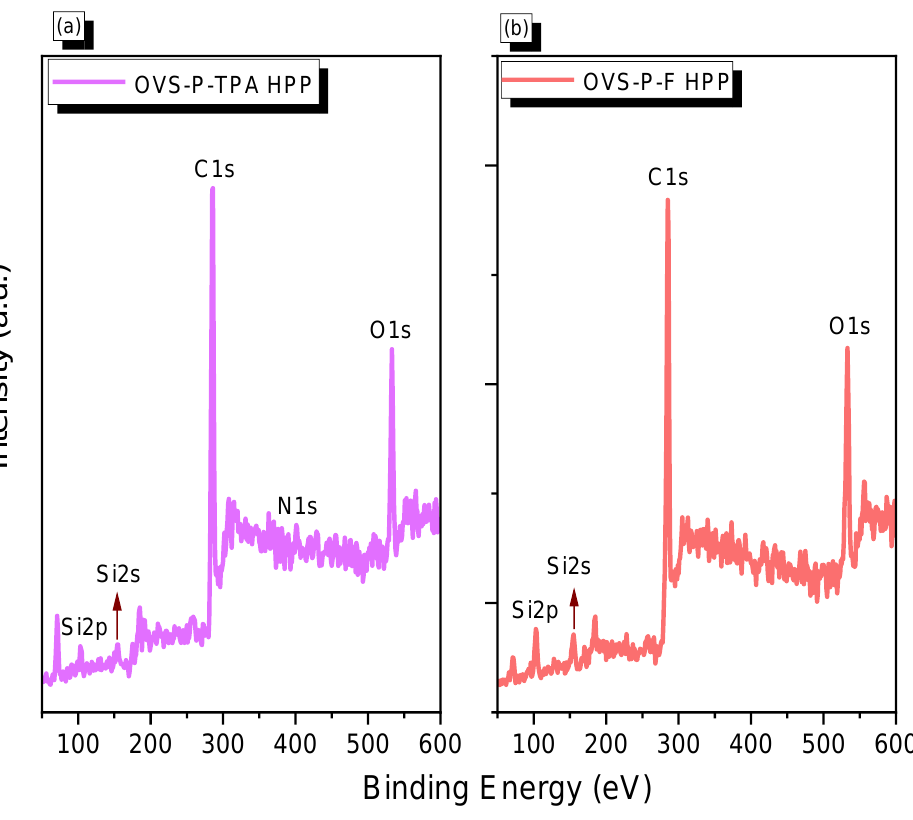
Figure 2. XPS analysis of ( a ) OVS-P-TPA HPP and ( b ) OVS-P-F HPP.